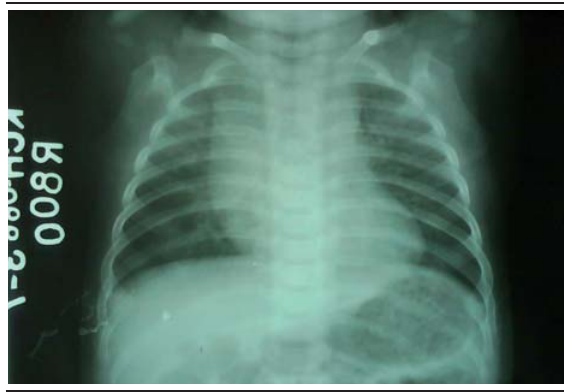
Figure 1. Normal chest X-ray